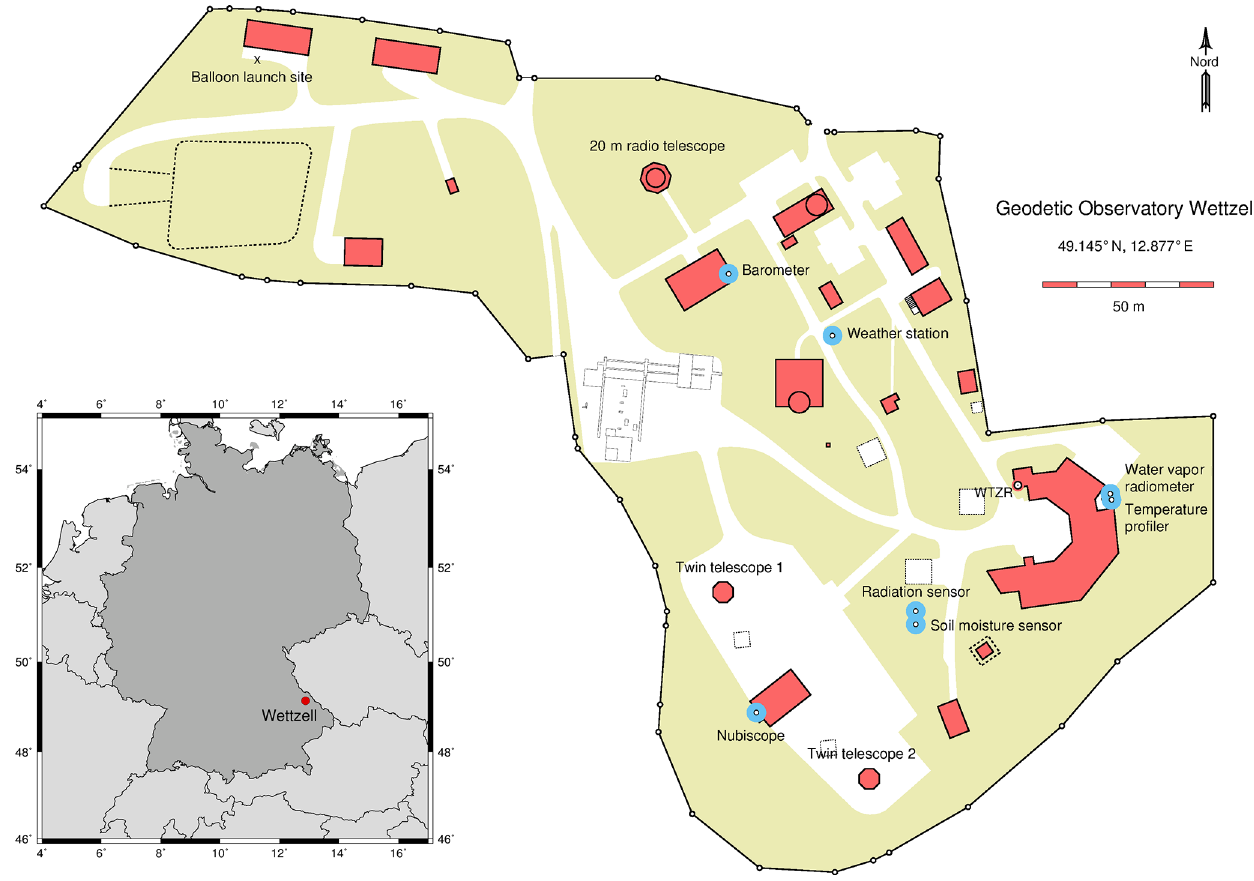
Figure 1. The Geodetic Observatory Wettzell, with atmospheric sensors highlighted in